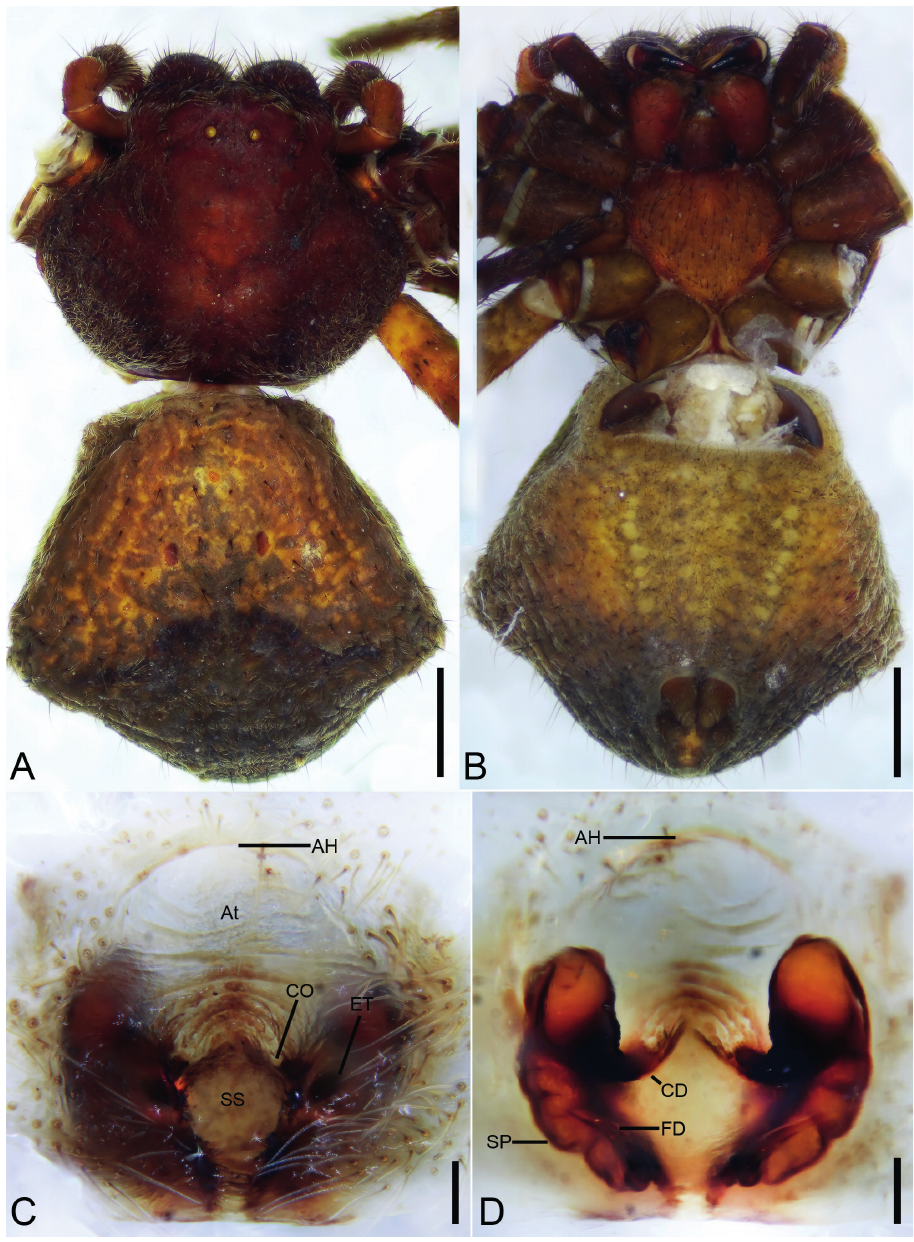
Figure 3. Angaeus xieluae sp. nov., female paratype. A habitus, dorsal view B same, ventral view C epi- gyne, ventral view D same, dorsal view. Abbreviations: AH – anterior hood, At – atrium, CD – copulatory duct, CO – copulatory opening, ET – epigynal teeth, FD – fertilisation duct, SP – spermatheca, SS – sep- tal stem. Scale bars: 0.5 mm ( A, B ), 0.1 mm ( C, D